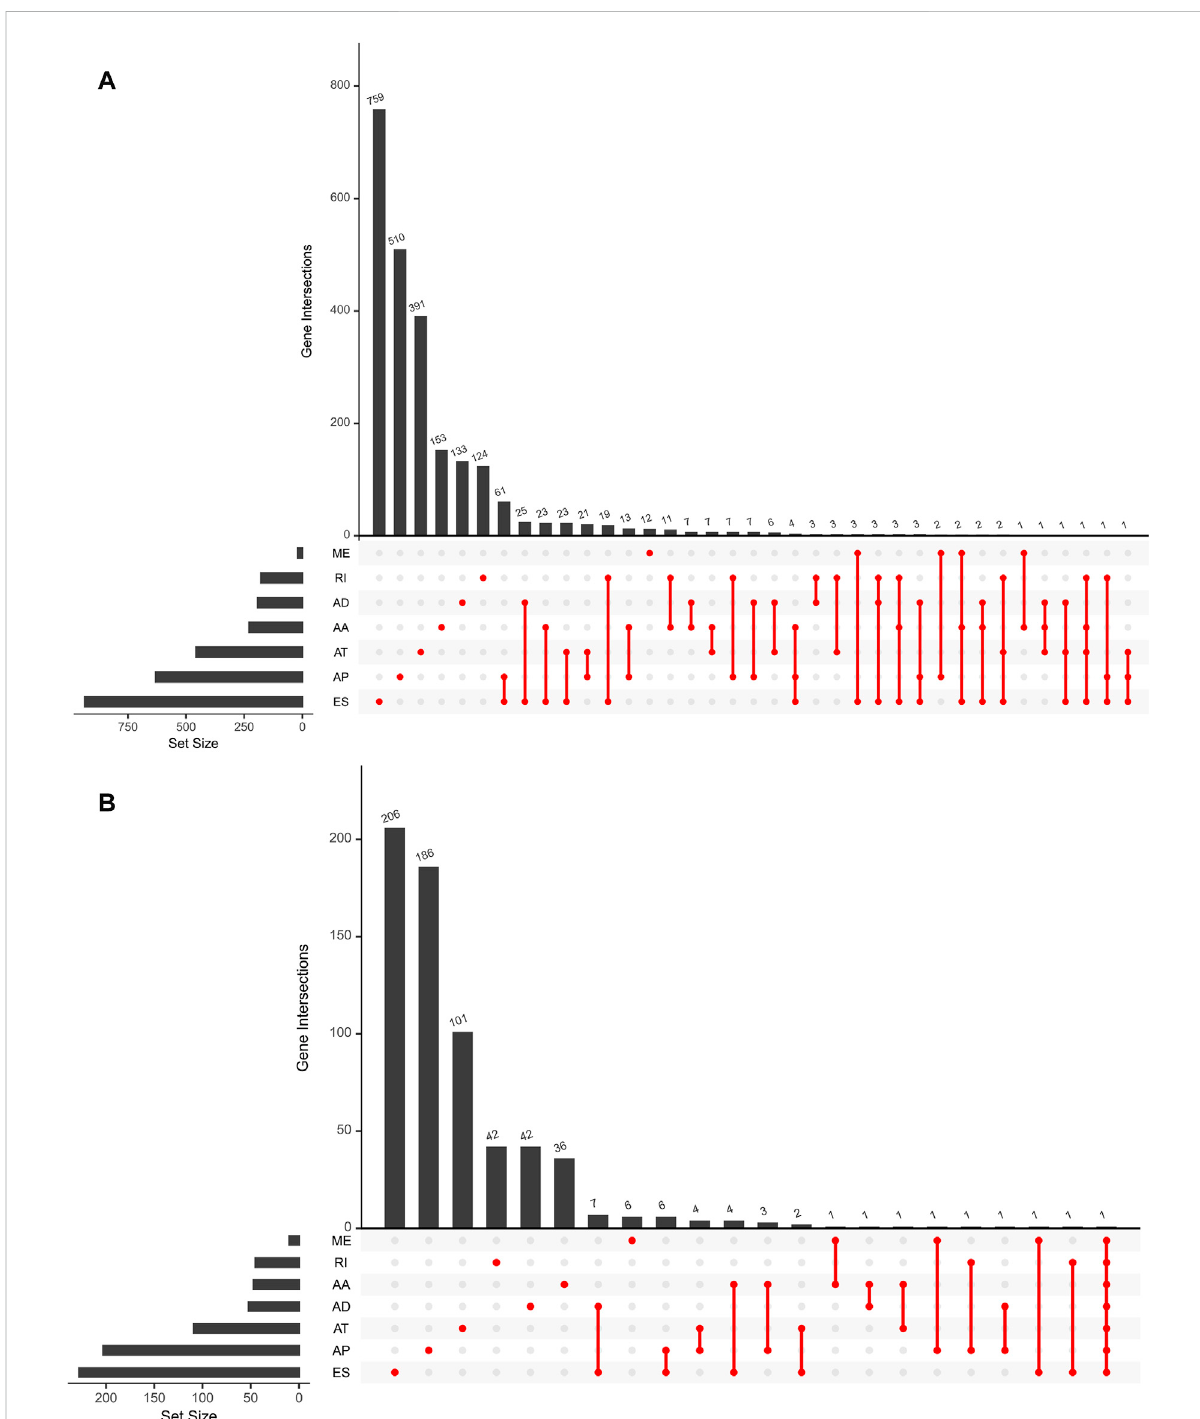
FIGURE 3 (A) . An upset plot depicting interactions between distinct m6A methylation regulator-related AS types In LGG. (B) . Upset plot showing survival- associated m6A methylation regulator-related AS